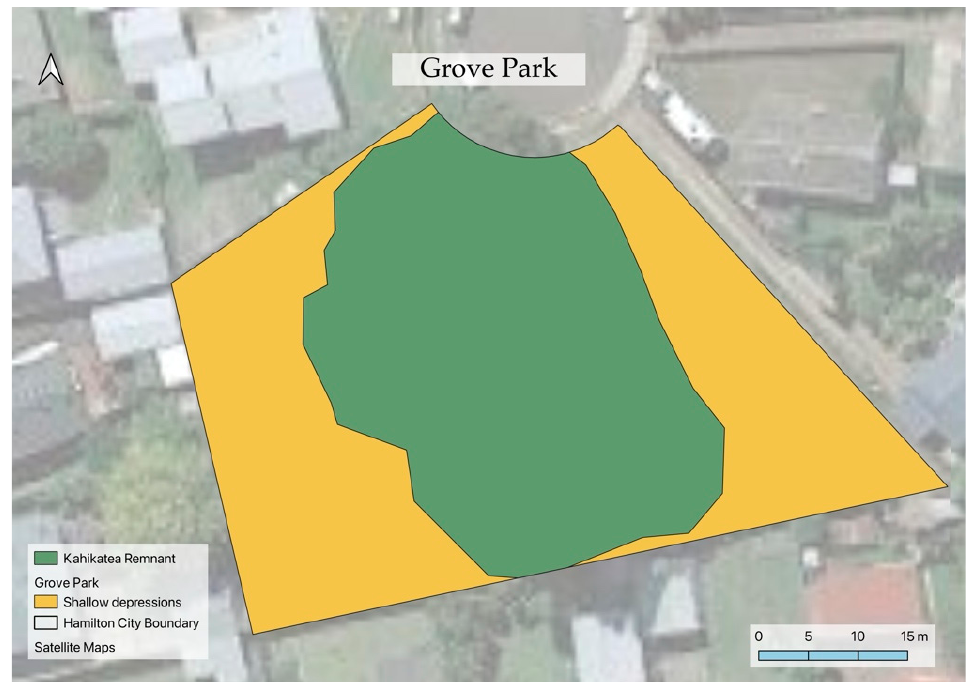
Figure B2. Hillcrest Park’s planting zones. Hilly land (rimu/tawa forest); low rolling hills—foot- slopes (pukatea-kahikatea forest); low mounds (mixed conifer-broadleaf forest) and shallow depres- sions (kahikatea semi-swamp forest). Pioneer species of the alluvial plains include Cordyline austra- lis , Melicytus ramiflorus , and Myrsine australis . Alternatively, pioneer species of the hills include Hedycarya arborea , Podocarpus totara and Alectryon excelsus [18].